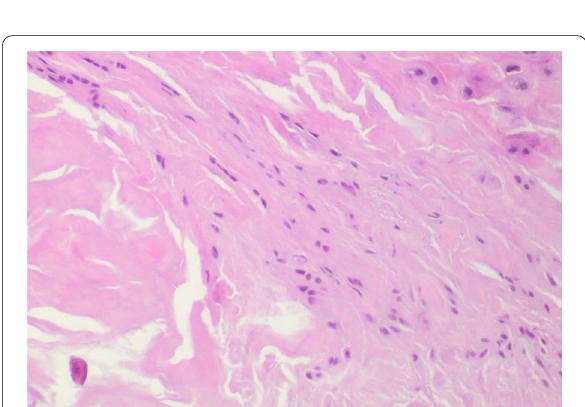
Fig. 3 Light photomicrograph of the newly regenerated host tissue by the implant at 6 months. This is dense, regularly oriented connective tissue. There was no evidence of any remnants of the collagen implant. (Hematoxylin and eosin) 100. Pathologists × reported it as “Ligamentous‑Tendinous fibrous tissue without relevant morphological